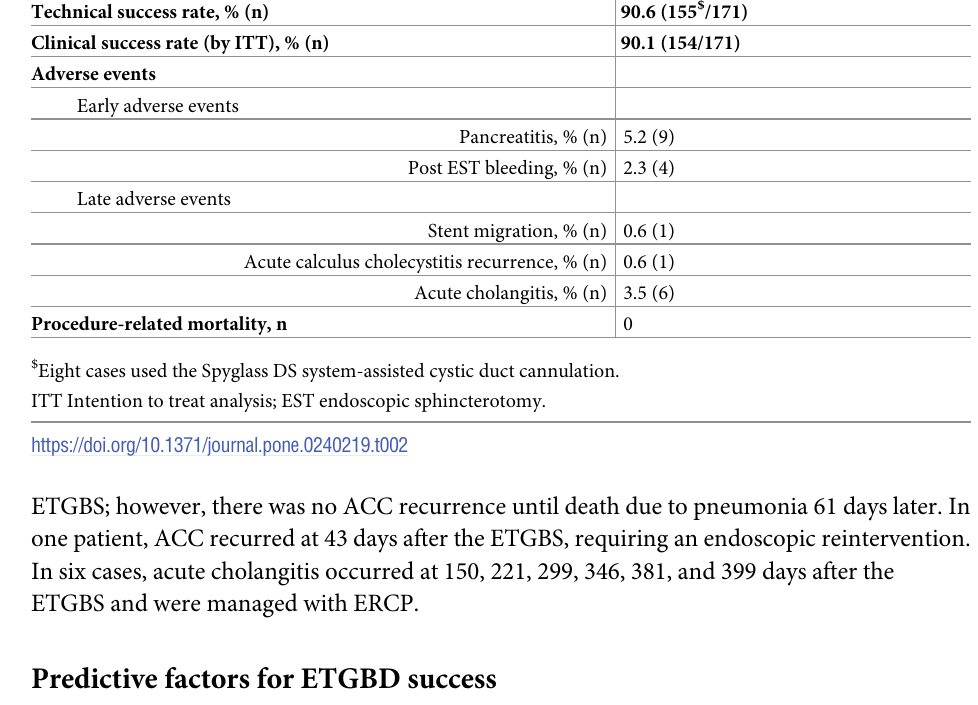
Table 3. Logistic regression analysis of factors for successful endoscopic transpapillary gallbladder drainage. Factor